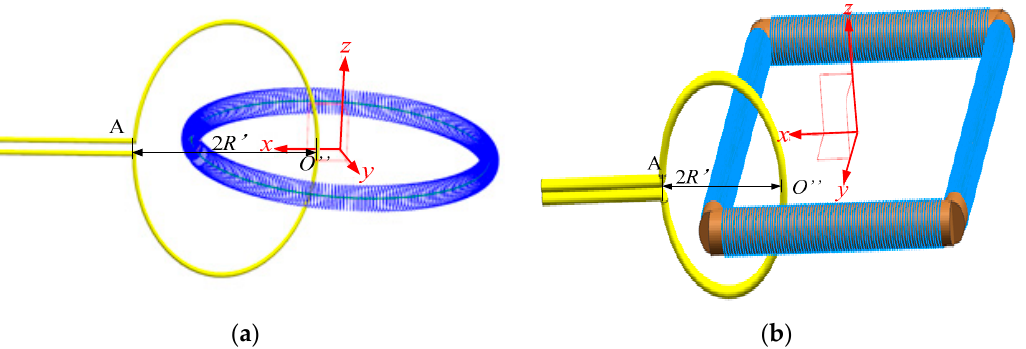
Figure 15. Curved conductor going vertically through the coils. ( a ) The Rogowski coil of the oval skeleton; ( b ) the Rogowski coil of the rectangular skeleton.